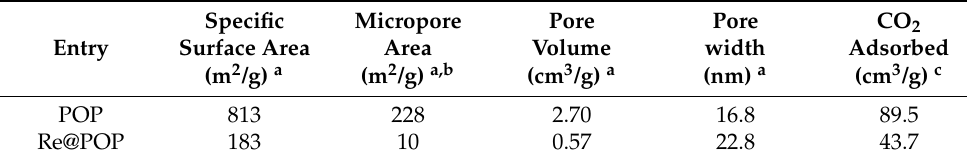
Table 1. N 2 and CO 2 physisorption results on POP and Re@POP *.